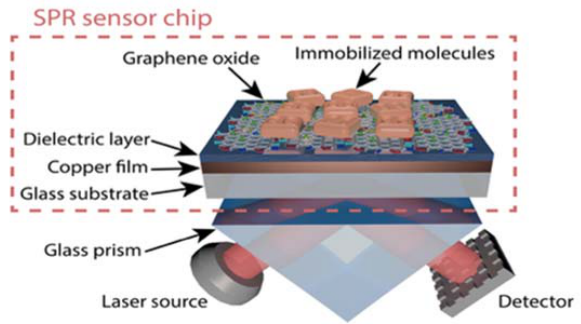
Figure 11. Schematic representation of the surface plasmon resonance (SPR) biosensor comprising the SPR sensor chip based on plasmonic copper films coated with a dielectric layer to protect against oxidation. The prism and sensor chip substrates are made of the same type of glass, which allows for an efficient optical connection. The immobilization of biomolecules on the biosensor surface can be achieved using a graphene oxide linking layer deposited atop the dielectric layer. Reprinted with permission from ref. [79]. 2018 American Chemistry Society.